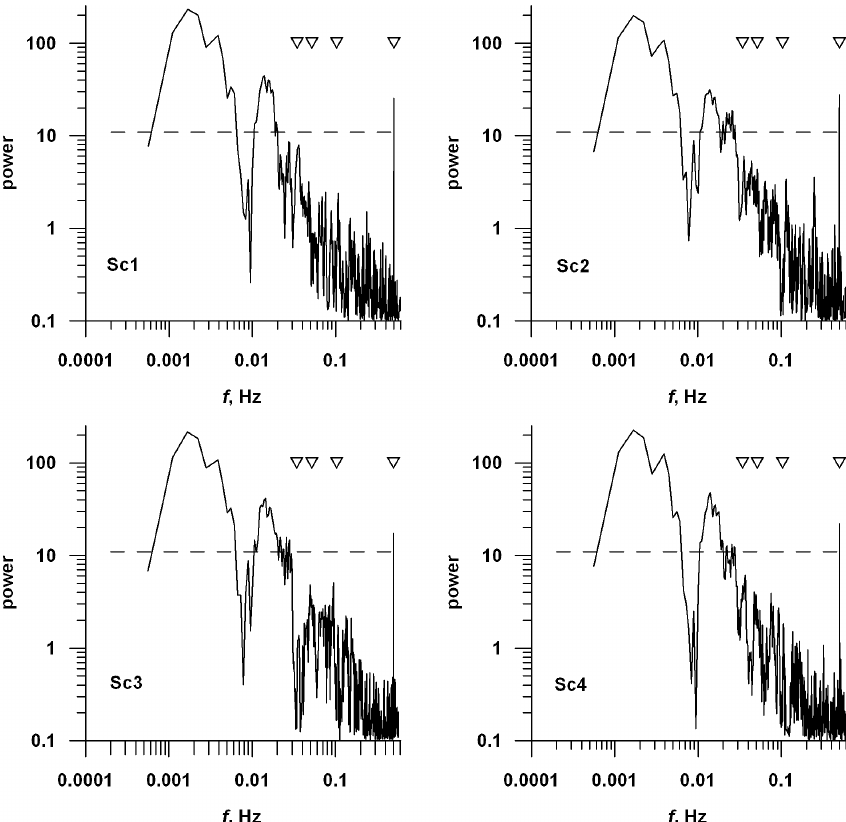
Fig. 3. Periodograms for wave energy densities measured at the foreshock boundary crossed by Cluster spacecraft on 29 April 2001 (event 47). Dashed lines correspond to the significance level of 0.05. Abscissas of triangles correspond to 0.33 f Bi , 0.5 f Bi , f Bi , and 0.5Hz. The frequency range of interest is located between the 1st and 3rd triangles, while the last one shows the position of peak resulting from spacecraft